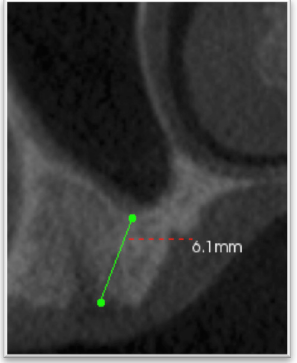
Fig. 5. Bone height from the sinus fl oor to the ridge crest.